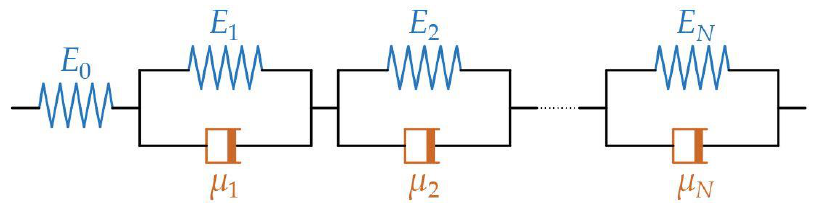
Figure 1. Generalised Kelvin–Voigt model.